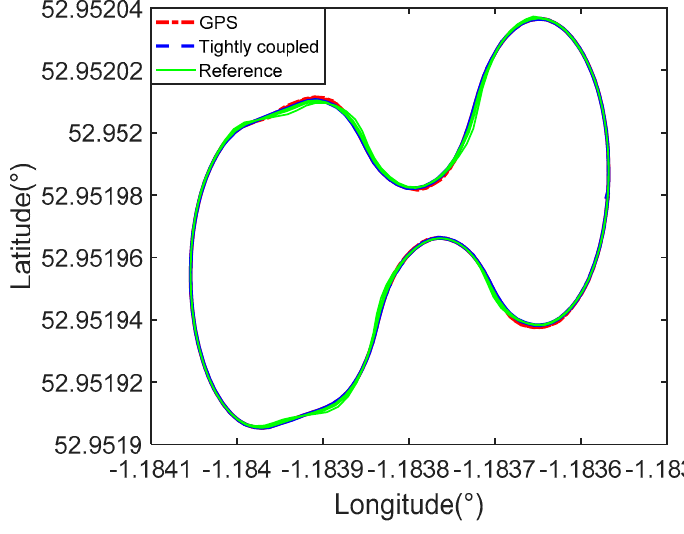
Figure 4. The trajectories of the three results.